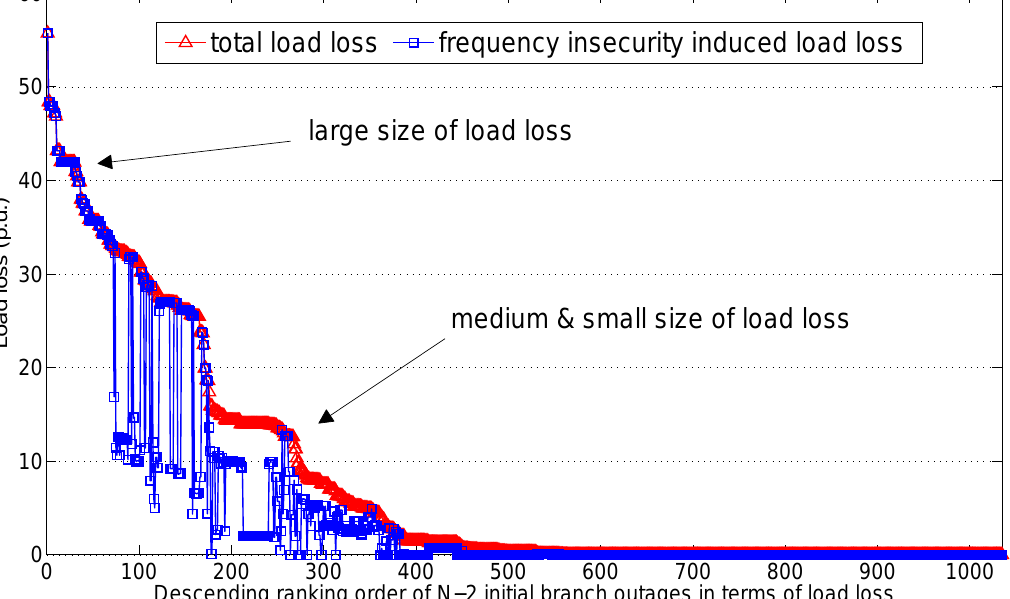
Figure 8. Statistics of load loss under N-2 initial branch outages in the IEEE 39-bus